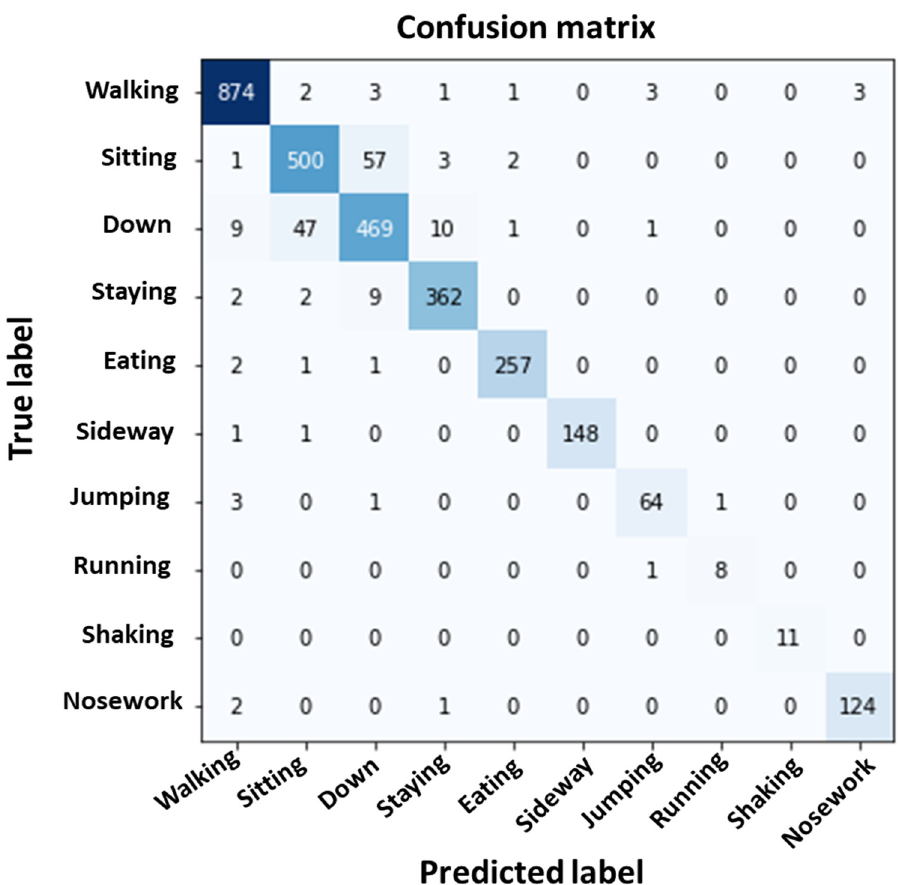
Figure 2. Confusion matrix without normalization.